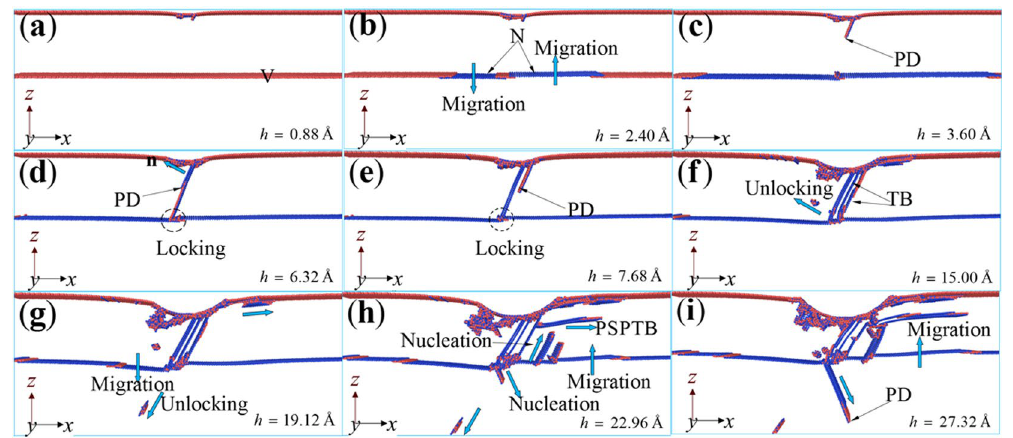
Figure 7. Microstructures evolution of YTB colored with atomic type at different depth. ( a ) h = 0.88 Å, ( b ) h = 2.40 Å, ( c ) h = 3.60 Å, ( d ) h = 6.32 Å, ( e ) h = 7.68 Å, ( f ) h = 15.00 Å, ( g ) h = 19.12 Å, ( h ) h = 22.96 Å, and ( i ) h = 27.32